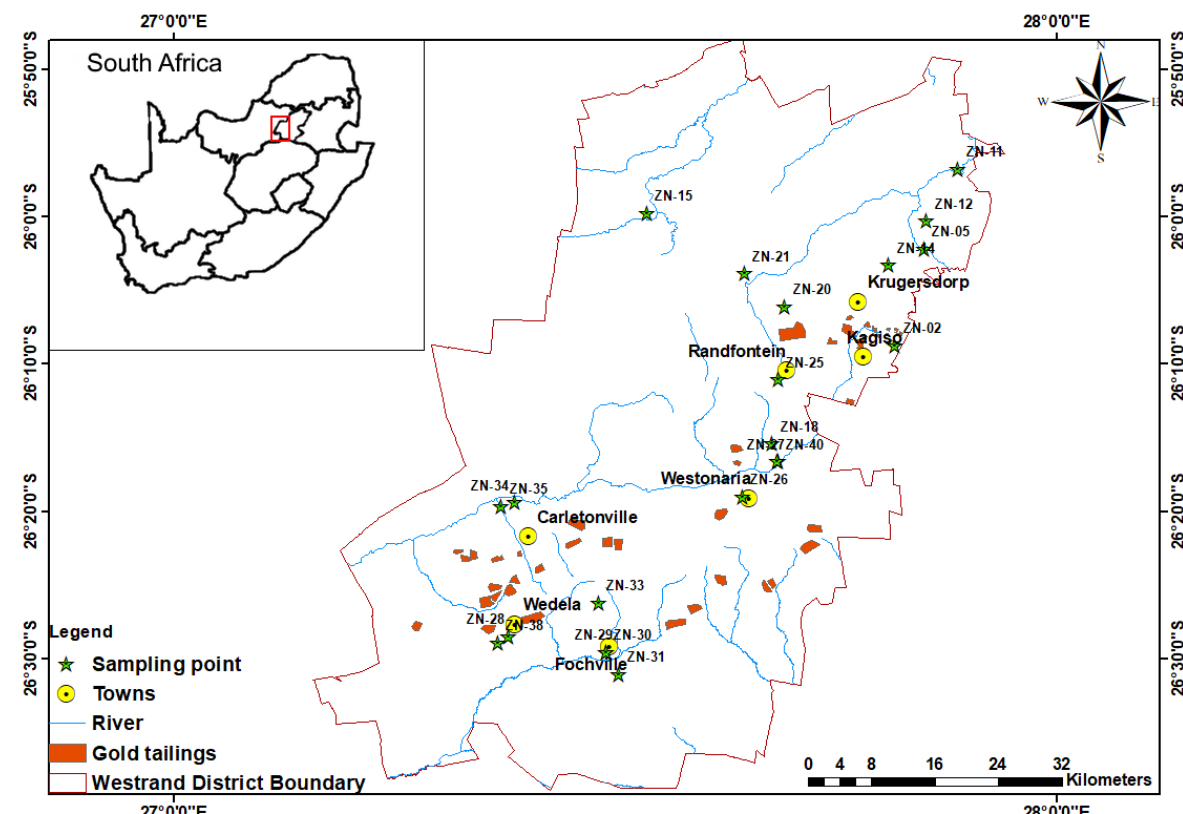
Figure 1. Locality map of the West Rand with sampling points and gold tailing dams.